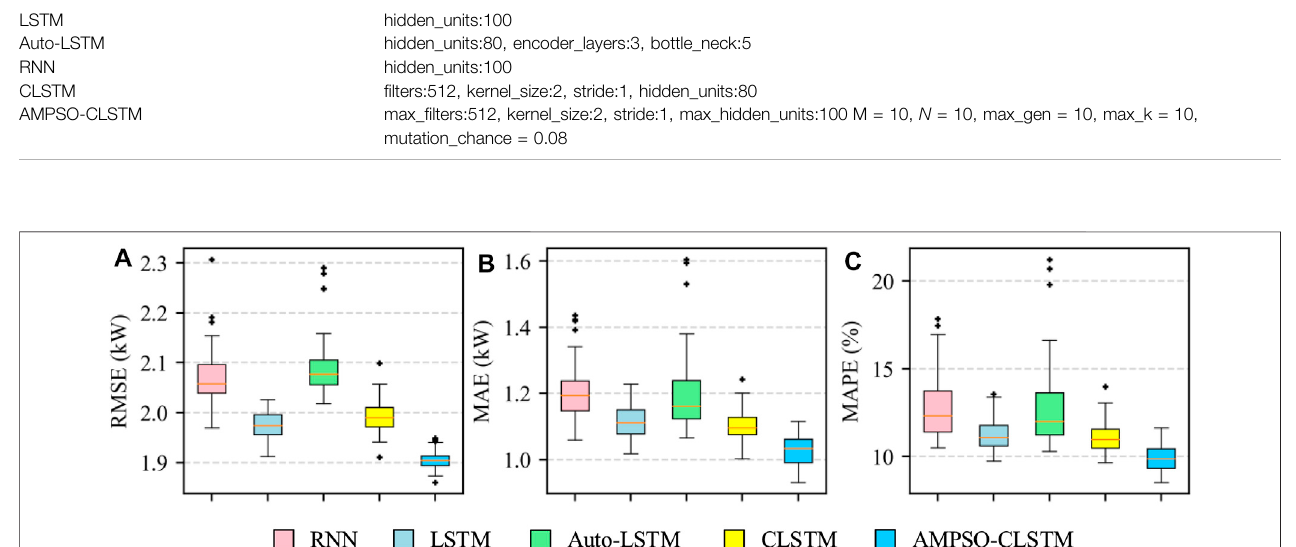
FIGURE 5 | Boxplots of error indexes for 50 independent runs on the DKASC data set. (A-C) are the RMSE, MAE and MAPE of all models,